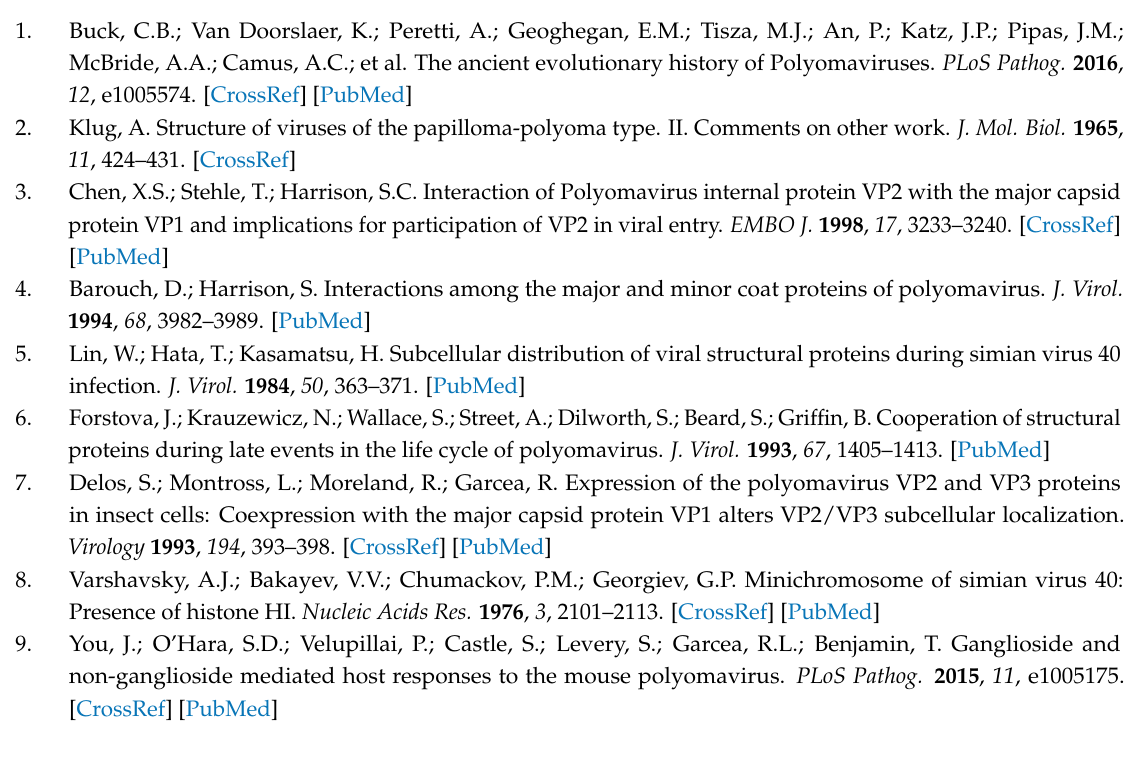
Figure S1: DNA sequence chromatograms of wt or mutant viruses. Figure S2: Nuclear assembly of the Mutant 2 virus and the wt virus. Table S1: Comparison of NLS signals strength in members of polyomavirus family. Acknowledgments: We are grateful to Boris Ryabchenko for assistance in PLA assay standardization, to Pavel Ulbrich and Miroslav Hylis for Electron Microscopy assistance and to David Liebl for providing a micrograph used for comparison in the Supplementary Figure S2D–G. This study was supported by the Grant Agency of Charles University (GAUK No. 359615), Grant agency of the Czech Republic (Project 16-07977S), by the Charles University in Prague (Project UNCE 204013), SVV grant (SVV-260426) and by the project BIOCEV—Biotechnology and Biomedicine Centre of the Academy of Sciences and Charles University (CZ.1.05/1.1.00/02.0109), from the European Regional Development Fund. The funders had no role in study design, data collection and analysis, decision to publish, or preparation of the manuscript. Author Contributions: Conceived and designed the experiments: Irina Soldatova, Sandra Hu é rfano, Jitka Forstov á , Levon Abrahamyan. Performed the experiments: Irina Soldatova, Sandra Hu é rfano, Terezie Prilepskaja. Analyzed the data: Irina Soldatova, Sandra Hu é rfano, Terezie Prilepskaja, Jitka Forstov á . Wrote the paper: Irina Soldatova, Sandra Hu é rfano, Jitka Forstov á . Edited the paper: Levon Abrahamyan. Conflicts of Interest: The authors declare no conflicts of